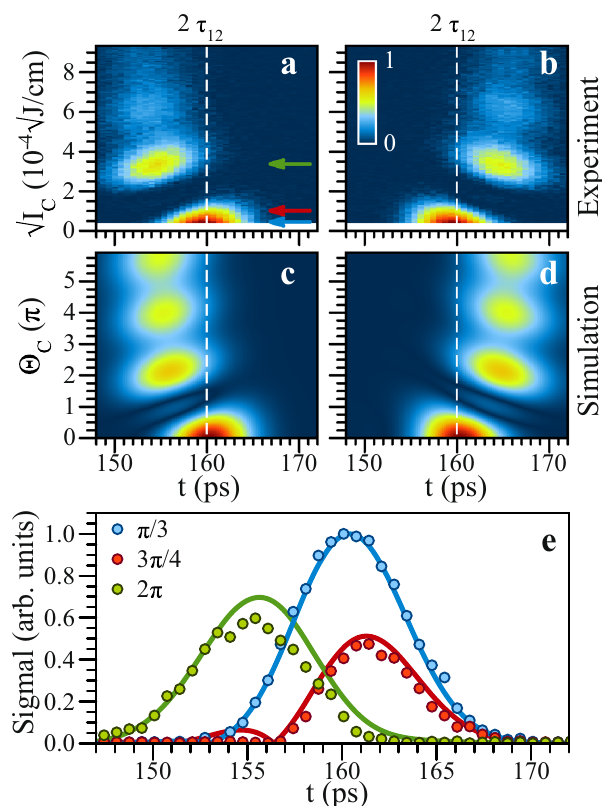
Fig. 4 Dependence on control pulse area. Temporal PE pro fi le as function ffiffiffiffi p I of the control pulse area / : a , b experimental data for contol pre- and C post-pulses; c , d corresponding simulations. The delay times for the pre- or post-pulses correspond to 33 and 27 ps, respectively, τ 12 = 80 ps, Θ 1 ≈ π /2, and Θ 2 ≈ π . e Temporal PE pro fi les for three different pre-pulse intensities I Θ = π /3 (blue), 3 π /4 (red), and 2 π (green). Symbols C corresponding to C and lines correspond to experiment and modeling, respectively. The associated intensities are labeled with arrows in a .